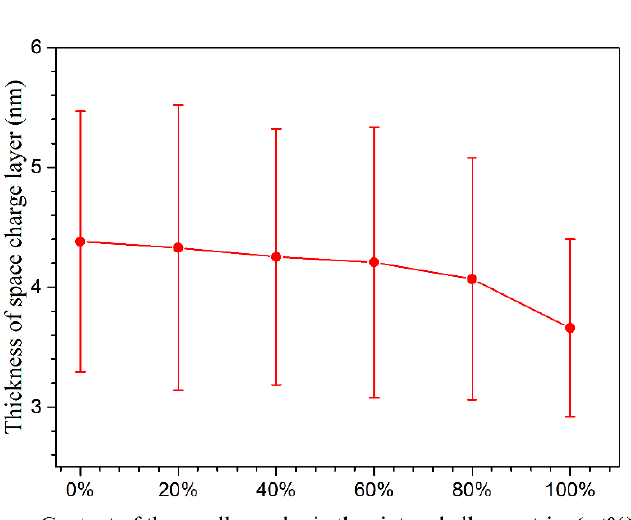
Figure 10. The thickness of space charge layer of passive film formed on sintered 7075 alloys; the standard deviation comes from five valid parallel results.